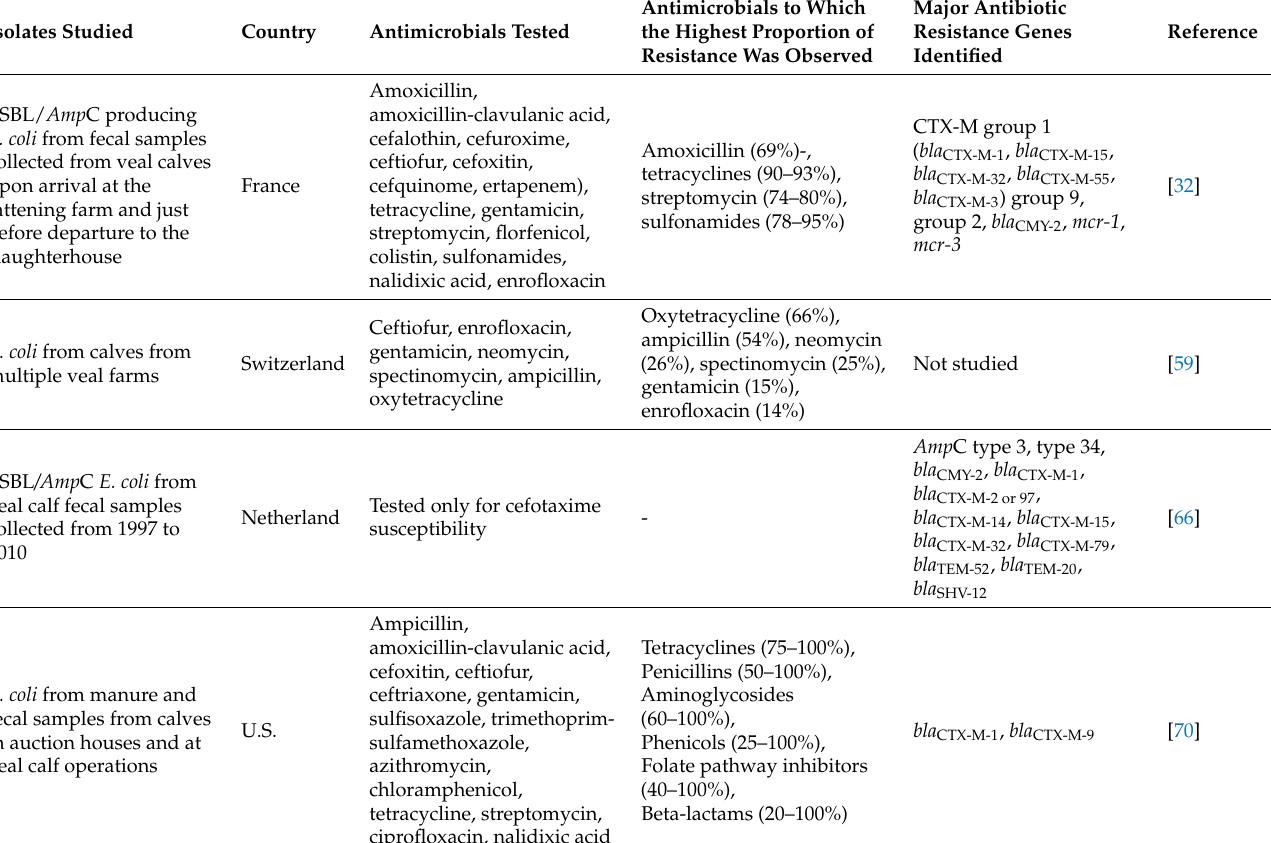
Table 3. Summary of research that studied resistance among enteric bacteria in surplus calves: The table below shows the source of the different isolates included in the study, the country in which the study was conducted, the panel of antimicrobials that were tested against the bacterial agent, antimicrobials to which highest proportion of resistance was observed and major antibiotic resistance genes that were identified in the